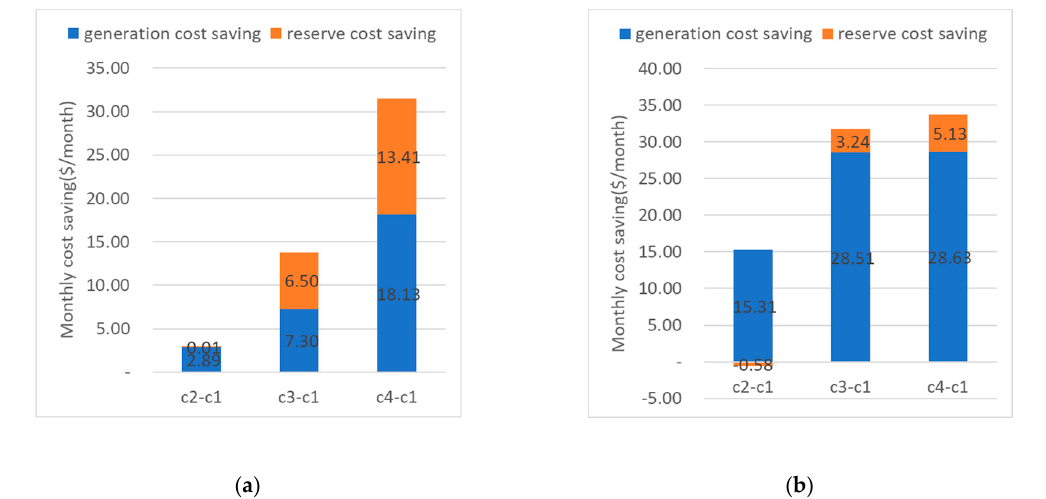
Figure 10. Monthly cost saving per EV under varying DR programs in 2019 and 2030: ( a ) 2019; ( b ) 2030.